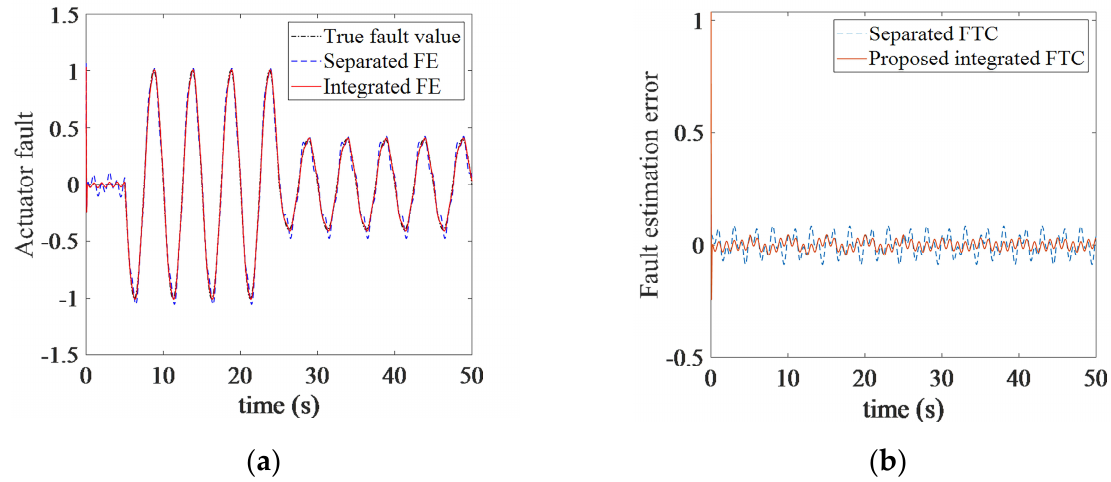
Figure 7. ( a ) True and estimated fault values in fault case 2; ( b ) fault case 2 fault estimation error.